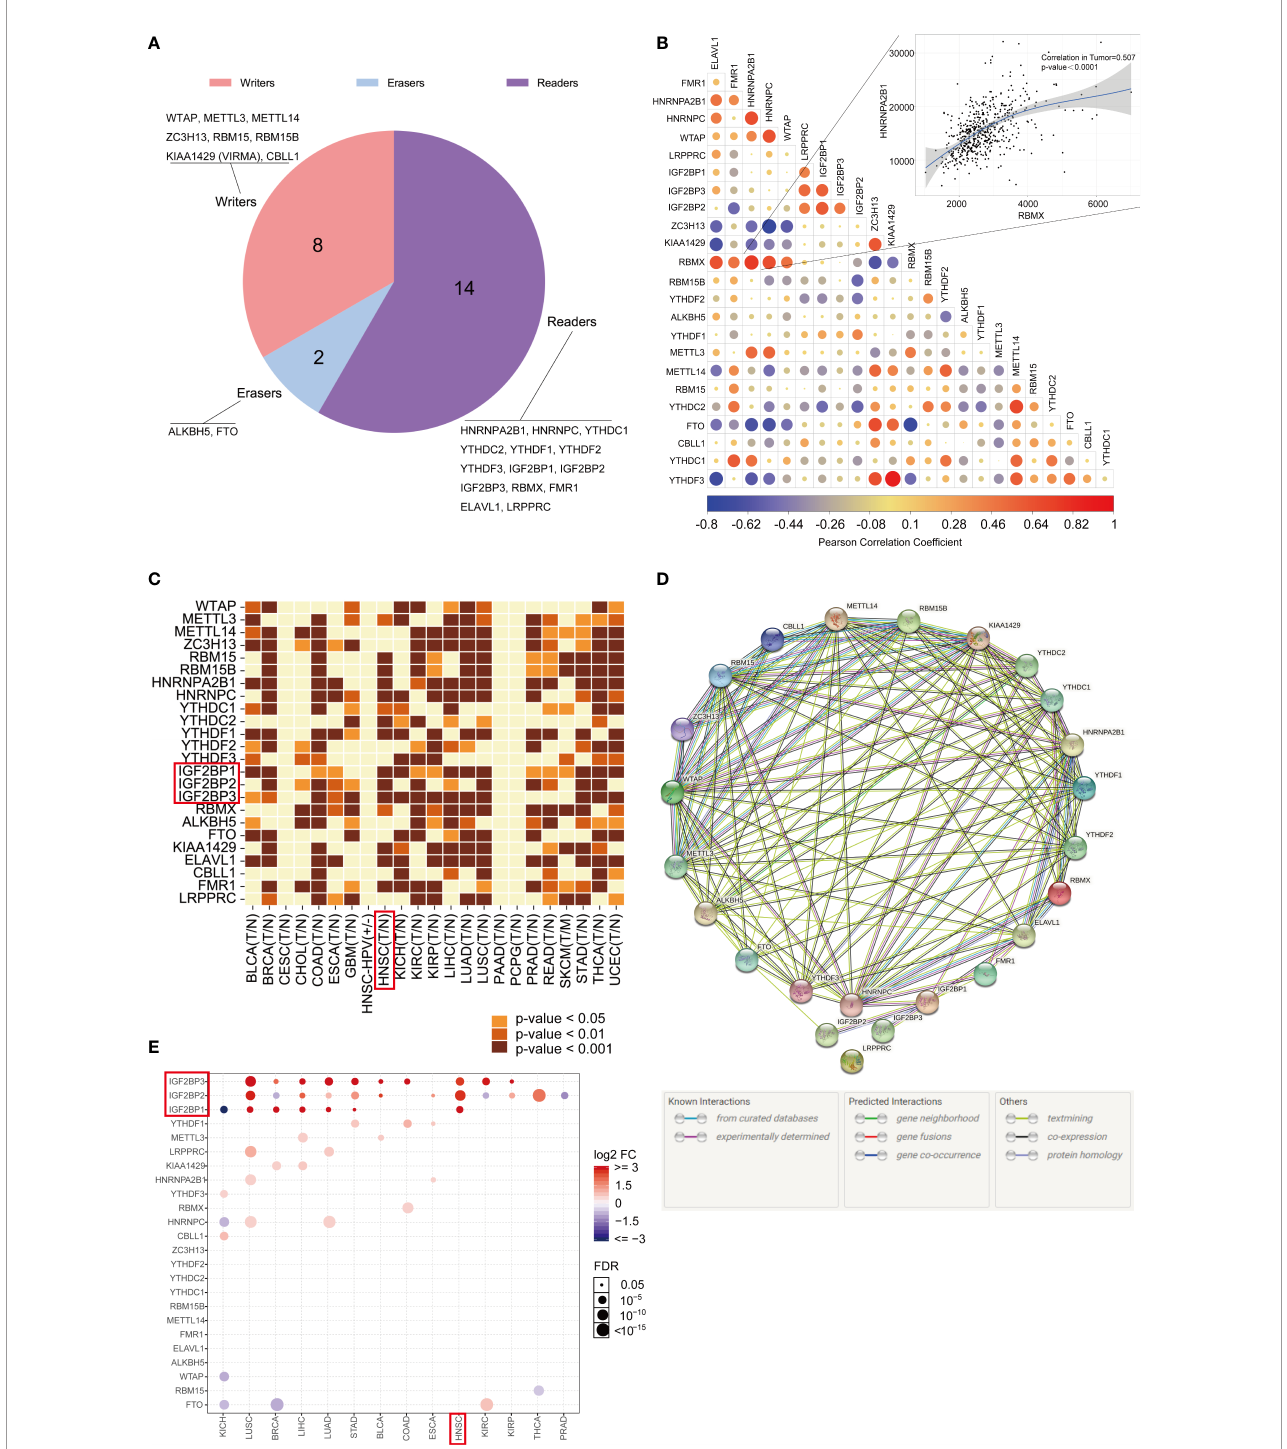
FIGURE 1 | Gene expression landscape of m 6 A regulators in pan-cancer. (A) The proportions of readers, writers, and erasers among m 6 A regulators. (B) Correlations between the expression of 24 m 6 A regulators. The correlation between RBMX and HNRNPA2B1 is illustrated as a scatter plot (Pearson correlation). A positive correlation is indicated in red, and a negative correlation is indicated in blue. The color intensity and size of the circle are proportional to the correlation coef fi cient. (C) The expression pro fi les of the 24 m 6 A regulatory genes in the TCGA pan-cancer dataset originating from the TIMER database. (D) The interactions among 24 m 6 A regulatory genes (STRING). (E) GSCALite was used to analyze the gene expression pro fi les of 24 m 6 A regulatory genes in 14 types of